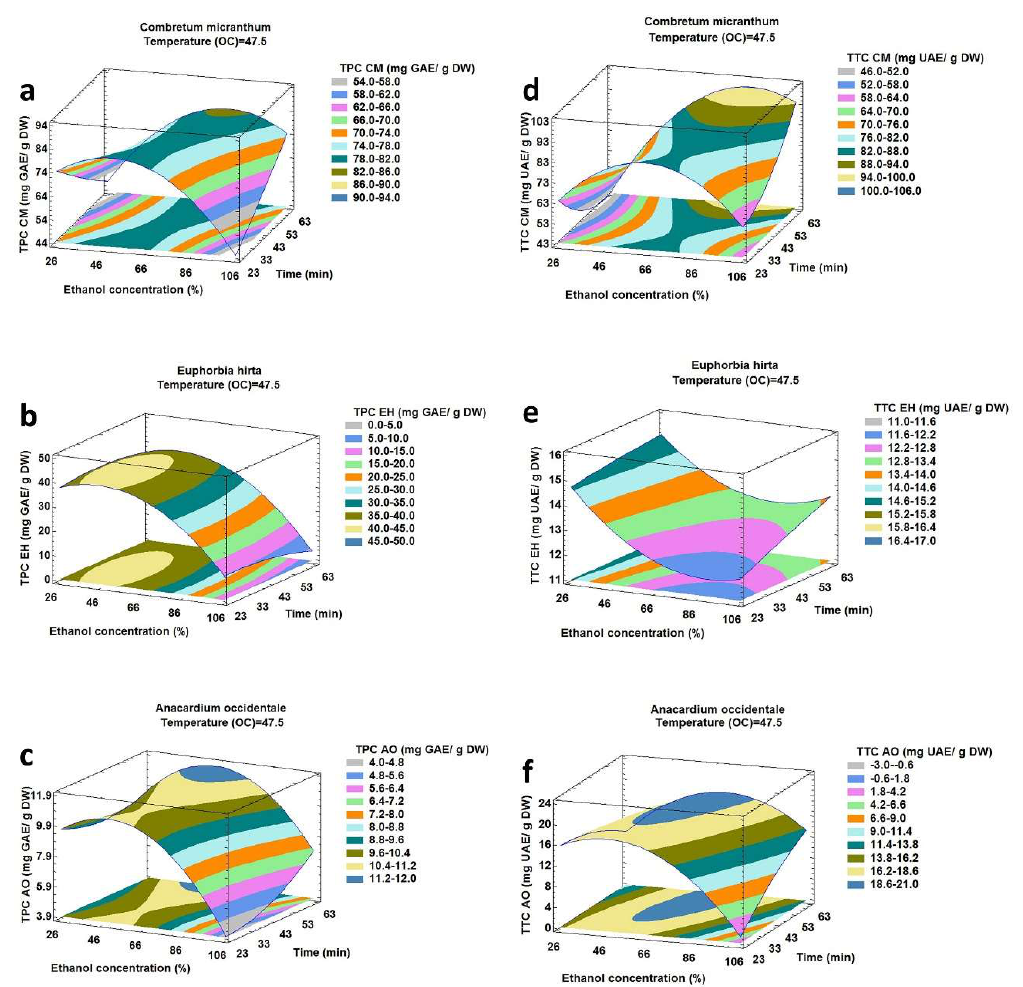
Figure 1. Response surface plot showing the effect of ethanol concentration and extraction time on total phenolic and total triterpenoid compounds from Combretum micranthum ( a , d ), Euphorbia hirta ( b , e ) and Anacardium occidentale ( c , f ) corresponding to extraction temperature of 47.5 °C. However, beyond a certain ethanol concentration, TPC decreased significantly. In fact,